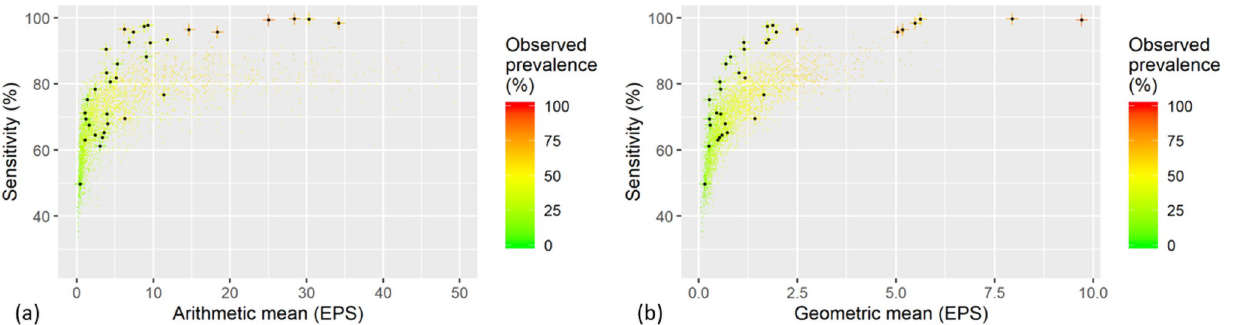
Fig 3. Estimated sensitivity in relation to infection intensity for arithmetic mean (a) and geometric mean (b) for duplicate Kato-Katz thick smears of a single stool sample. Black dots on crosses are the validation results from 34 locations in Uganda with observed prevalence above 10% selected from a survey with 146 schools and the dots are the simulated results. EPS,